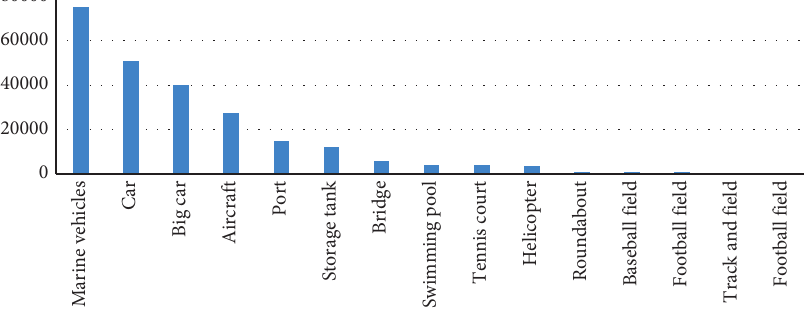
Figure 4: Distribution statistics of the DOTA training dataset.